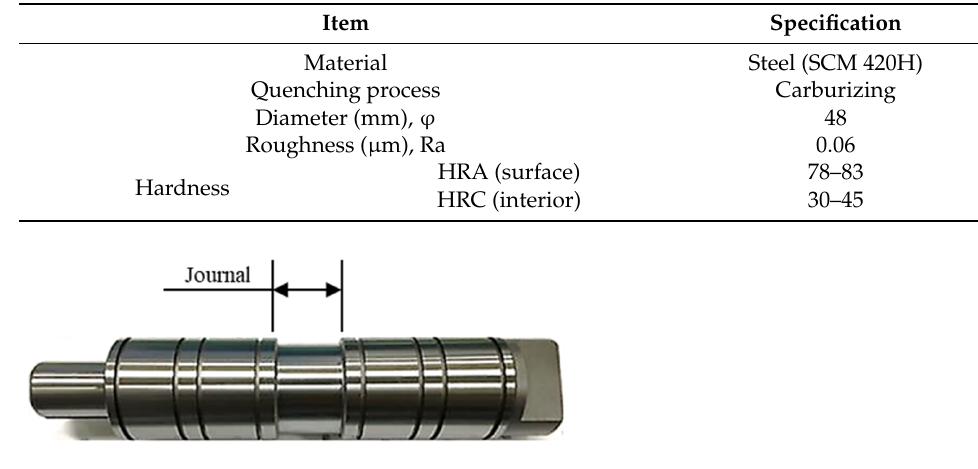
Figure 4. Test shaft.